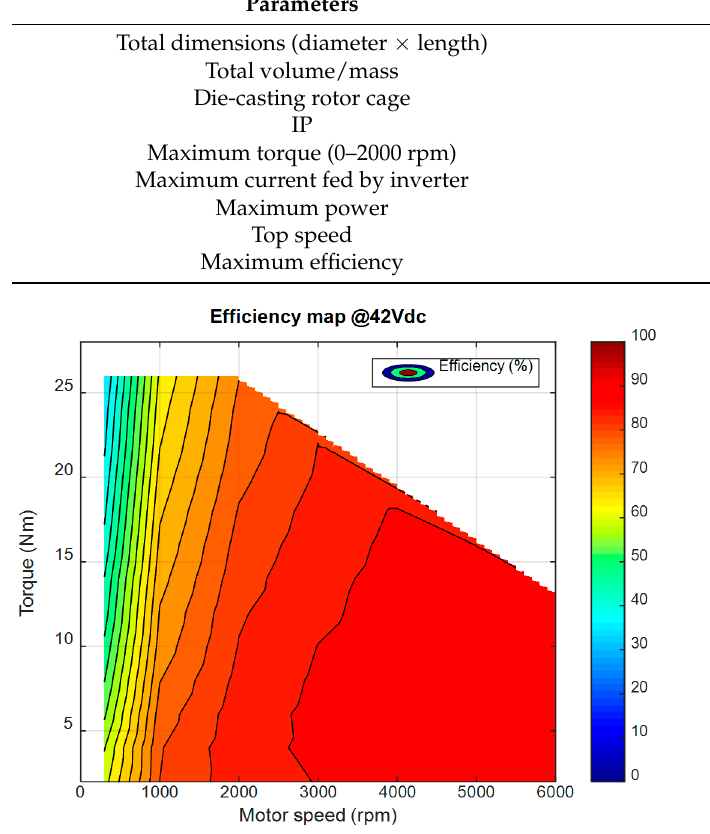
Figure 4. Efficiency map of E-engine for E-boat.